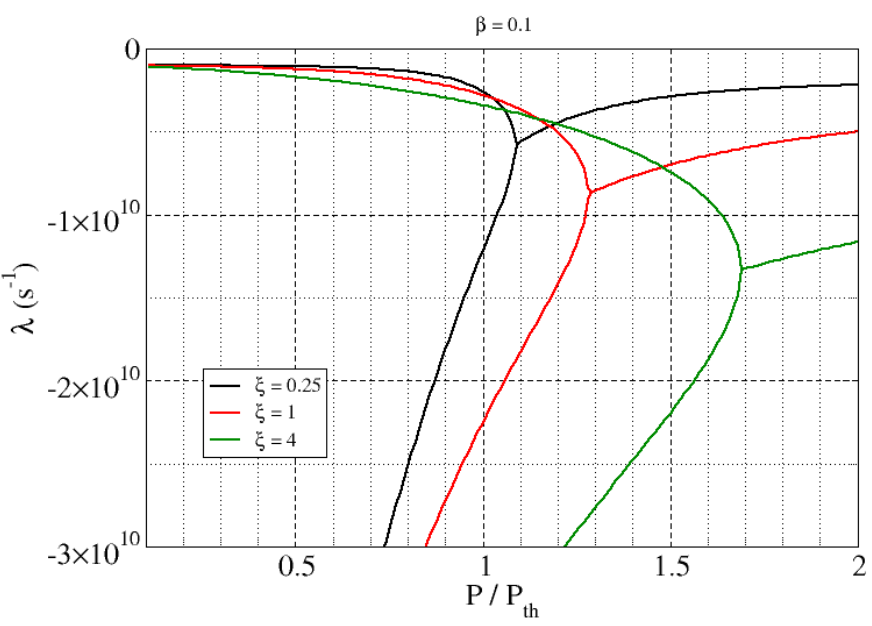
Figure 10. Real part of the eigenvalues derived from the stability analysis of the modified rate equations model, Equations (16) and (17). The different curves belong to different kinds of asymmetry (cf. figure legend). β = 10 − 1 . The chosen values of ξ , here and in the following figure, are those of